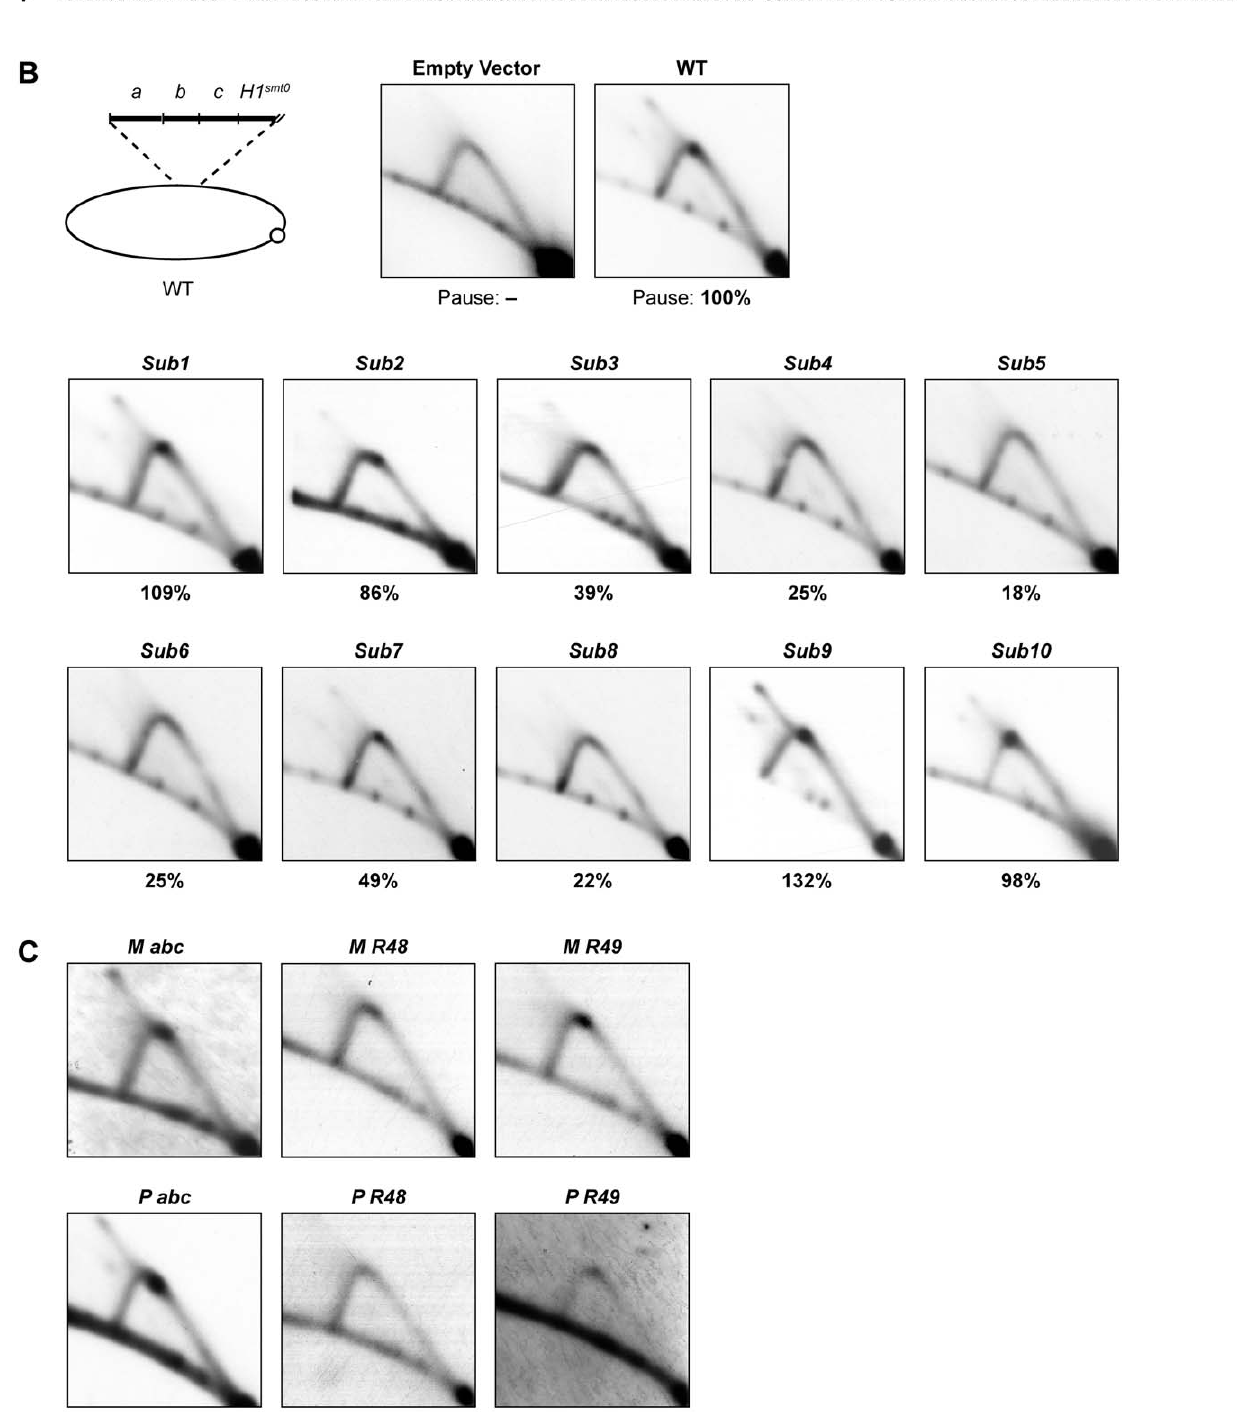
Figure 7. Characterization of the cis-acting region required for replication pausing. (A) DNA sequence of the abc region, aligned to the corresponding sequence in the P cassette, is given. The borders of a , b , and c regions are indicated by double arrows above the sequence. The sequence was divided into 10 segments and each segment was substituted by a random DNA sequence and denominated as substitution 1 to 10 ( Sub1 - 10 ). (B) 2D-gel analysis of plasmids that carry different substitutions within the abc region. Top left, line drawing of the parent plasmid. The